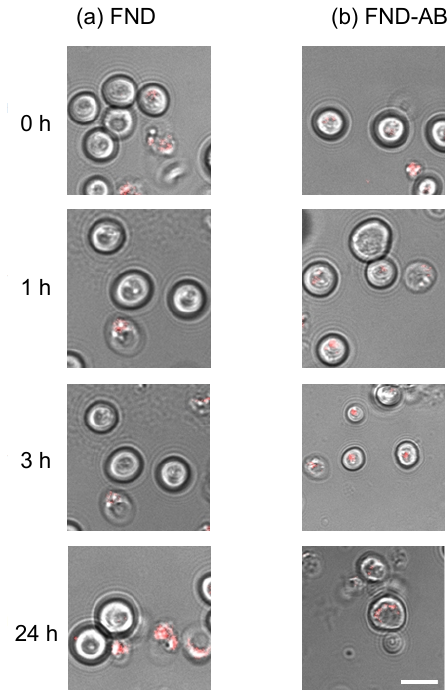
Figure 4. Position of particle (red) inside the cell at different time points. FND ( a ) and FND–AB ( b ) groups were followed between 0 and 24 h after the particles were taken up by the cells. Scale bars in all images are 0.75 µm.